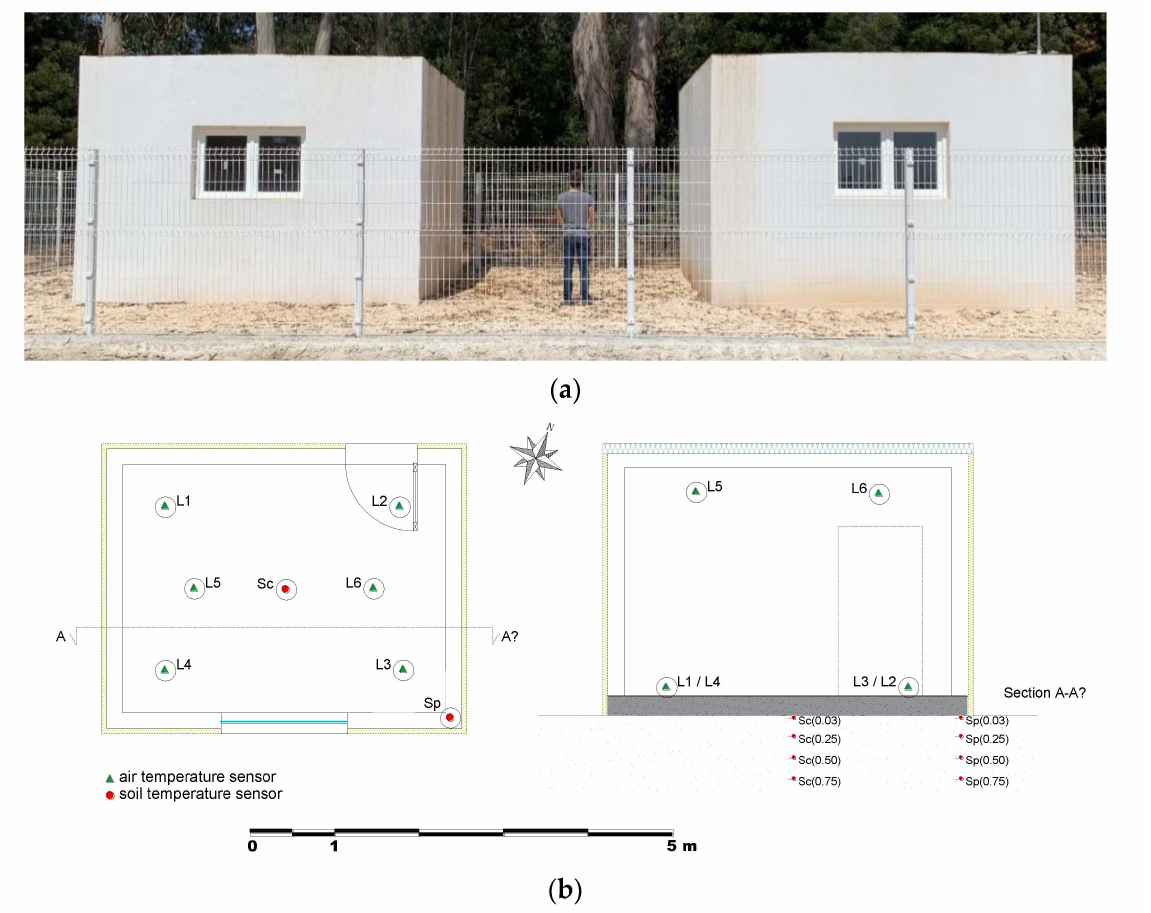
Figure 1. Experimental test cells: ( a ) external view; ( b ) plan view and section A-A?, indicating the monitoring equipment and scheme.